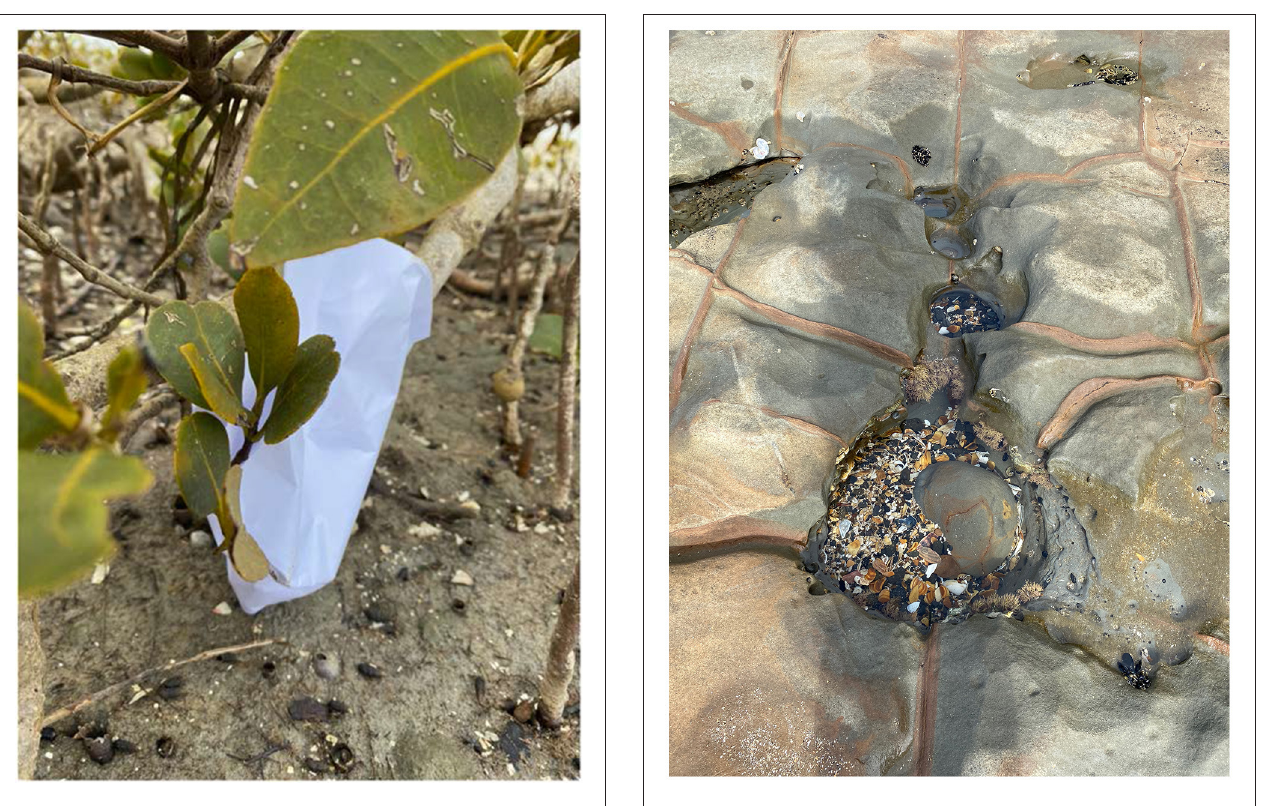
FIGURE 1 | When the storyboard washed up among the mangroves in the Waitemat ¯ a Harbour, also a Department of Conservation’s domestic bird reserve, T ¯ amaki Makaurau/Auckland, Aotearoa New Zealand. December 2020. Photo credit, Jennifer Nikolai.